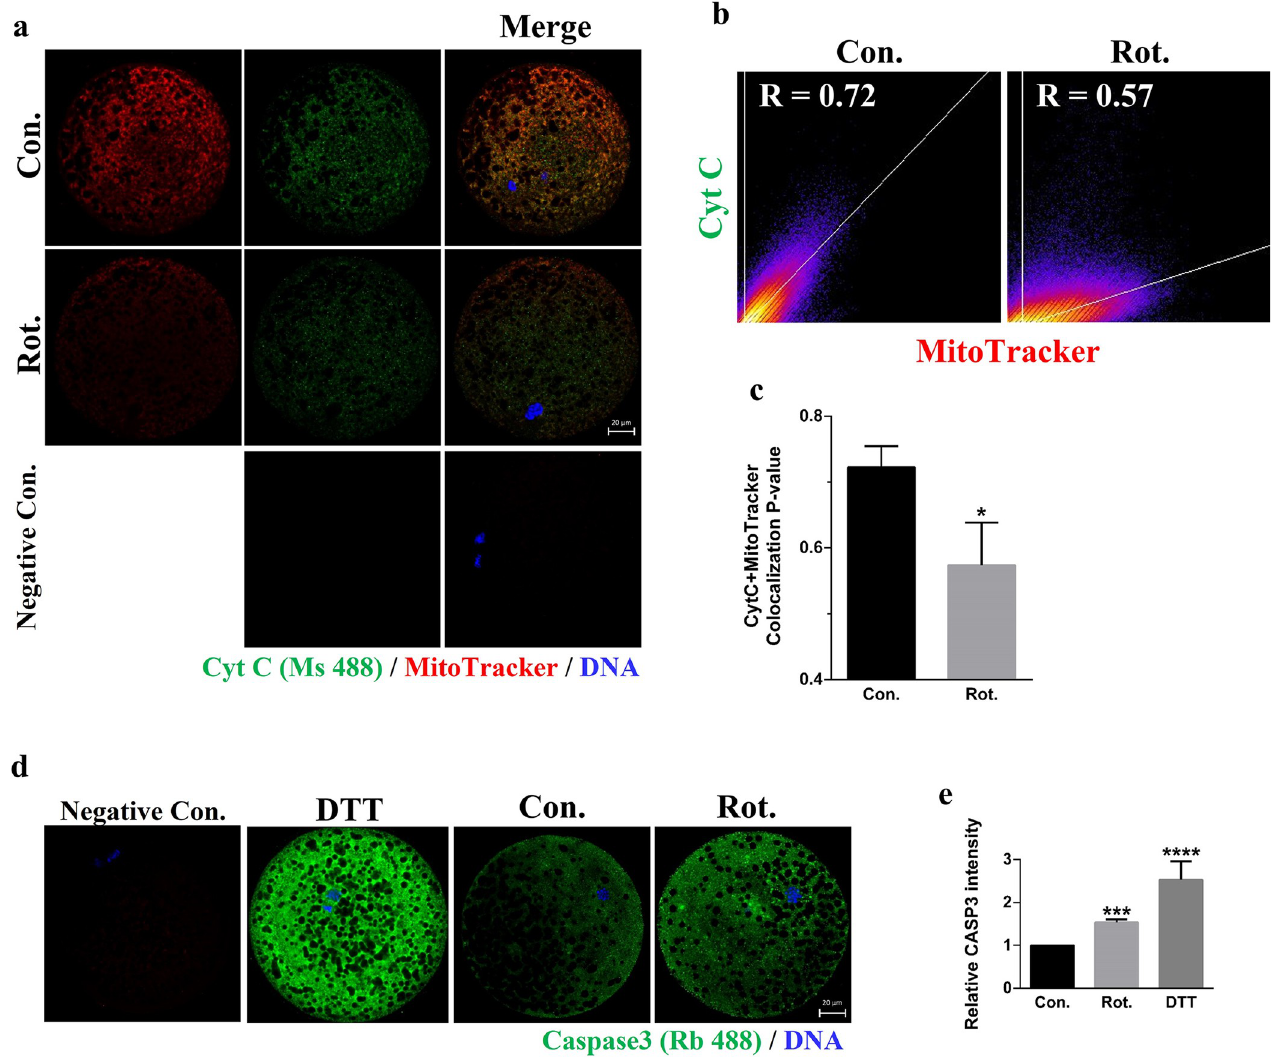
Fig 6. Rotenone leads to apoptosis in porcine oocytes. (A) Fluorescence images of cytochrome C and Mito-Tracker in porcine oocytes after rotenone treatment. Green = cytochrome C, red = Mito-Tracker, blue = DNA. Scale bars represent 20 μ m. (B) Colocalization graphs of cytochrome C and Mito-Tracker in the control and rotenone-treated groups. x-axis: MitoTracker; y-axis: TOM20. (C) Pearson value of colocalization of cytochrome C and Mito-Tracker in the control and rotenone-treated groups, which could indicate activation of apoptosis (n = 50). (D) Representative images of caspase3 intensity in the positive control (DTT), control and rotenone-treated groups. Green = caspase3, blue = DNA. Scale bar represents 20 μ m. (E) Relative fluorescence intensity of caspase3 in the control and rotenone-treated groups (n = 19). Con., control group. Rot., 3 μ M rotenone-exposed group. Negative Con., only the secondary antibody was stained in mature oocytes as a negative control. � (P < 0.05), ��� (P < 0.001) ���� (P <